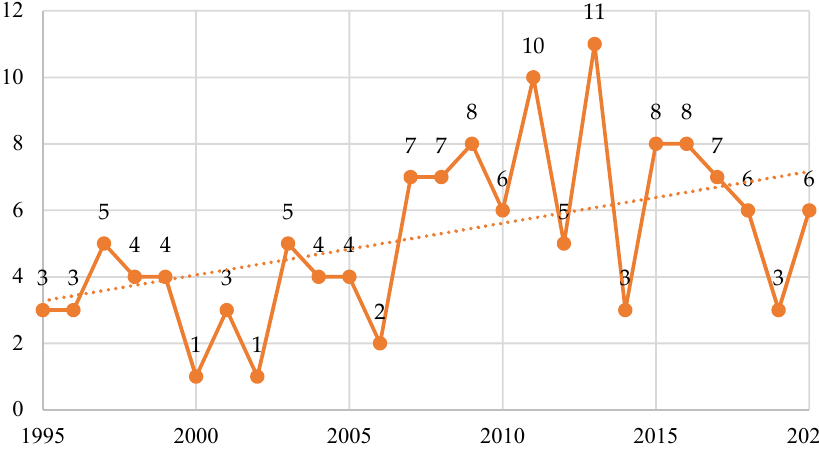
Figure 8. Search query: clozapine and early-onset schizophrenia in PubMed ® —total studies.